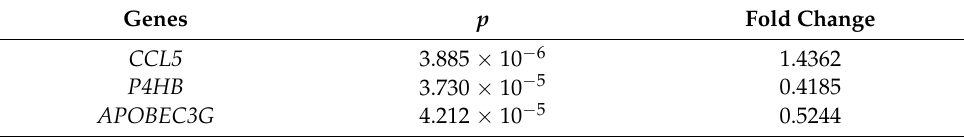
Table 2. Genes differentially expressed (DE) at the mRNA level in endemic pemphigus foliaceus patients compared to